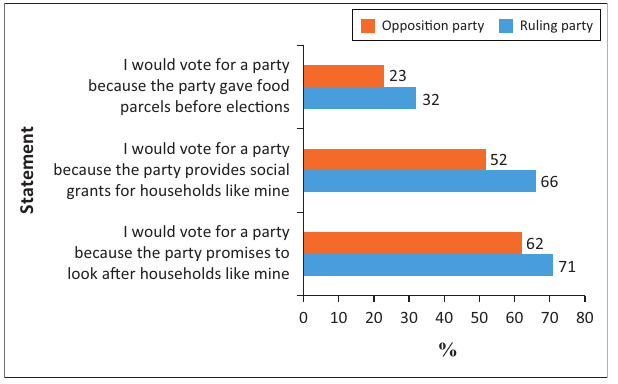
FIGURE 6: Agreements with statements relating to voting for a party based on potential benefits, by party preference.